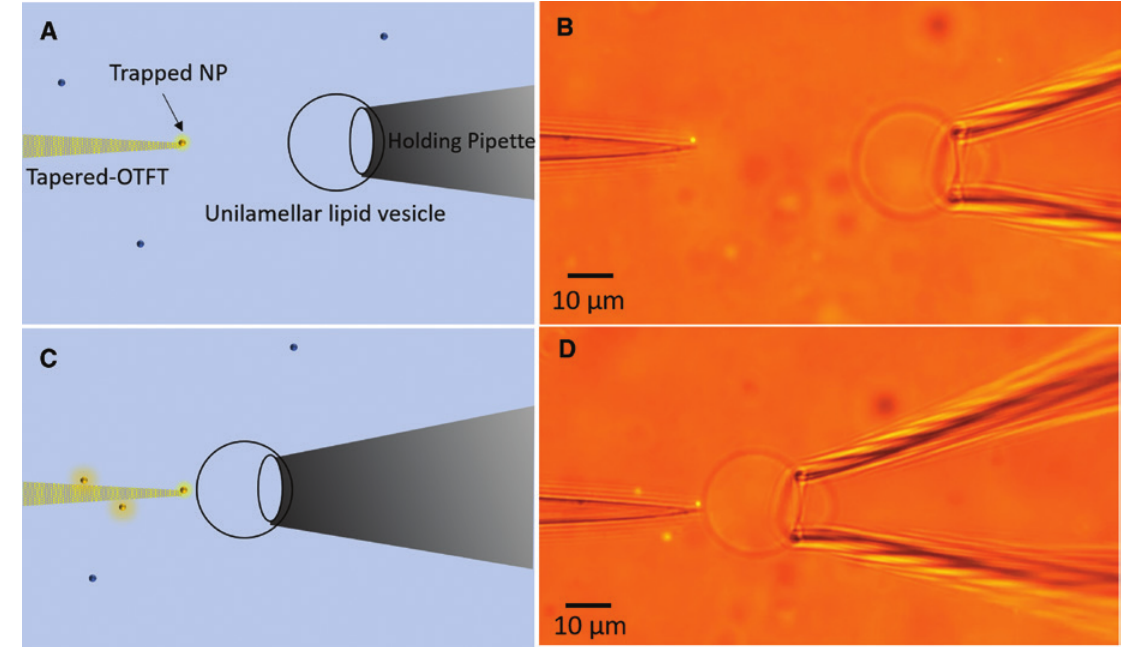
Figure 4: Direct delivery of